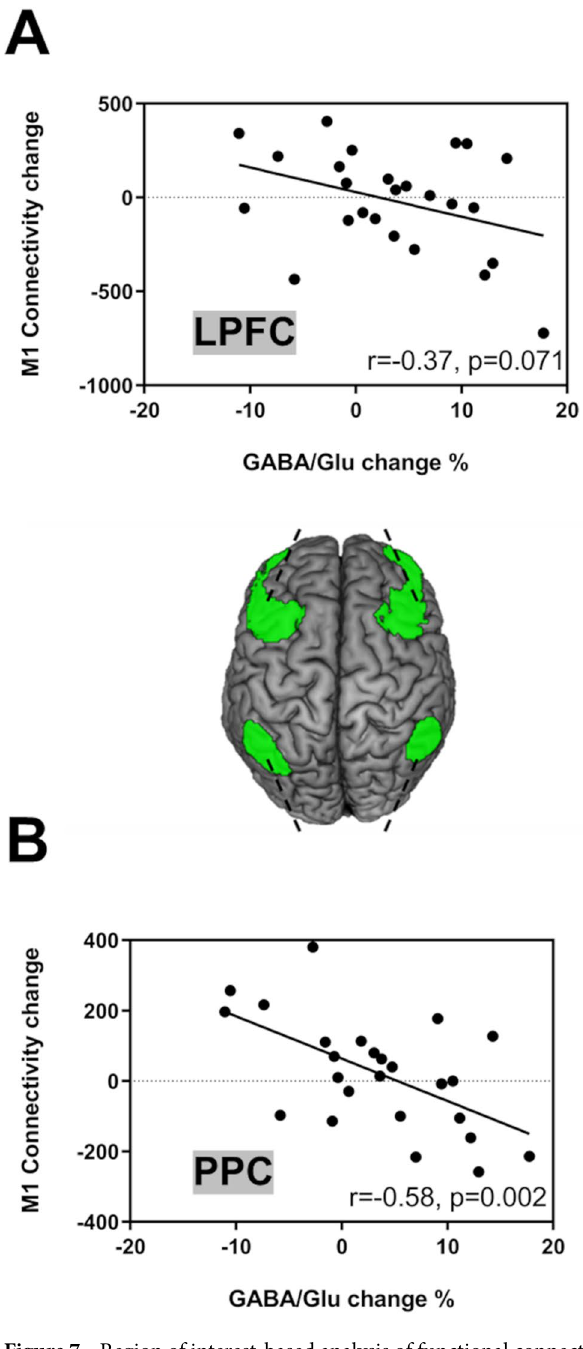
the changes in Glu/GABA ratio within the right M1 and M1 seed-based resting-state functional connectivity changes in ( A ) lateral prefrontal cortex (LPFC) and ( B ) posterior parietal cortex (PPC) of the FPN (green) after motor sequence